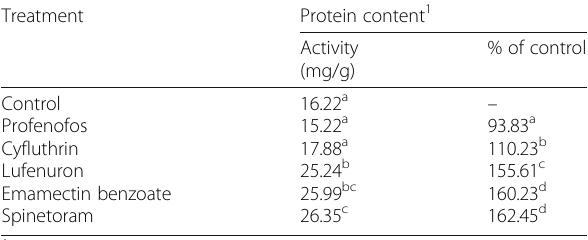
Table 4 In vivo effect of the tested compounds on the activity of protein content of S. littoralis larvae